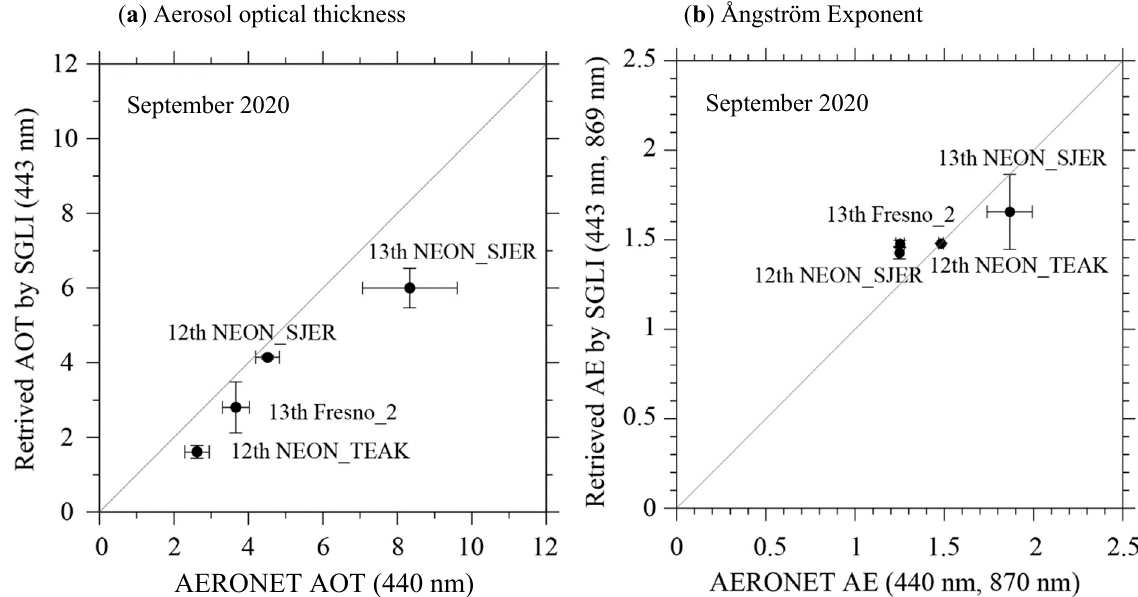
Figure 8. Comparison of aerosol properties derived from two different data collection methods— ground-based observations (AERONET) and satellite observations (SGLI). ( a ) Properties of aerosol optical thickness (AOT). ( b ) Properties defined by the Ångström exponent (AE). Satellite observation data are plotted on the vertical axis. Ground-based observation data are plotted on the horizontal axis. The three AERONET observation sites are plotted as NEON_SJER, Fresno_2, and NEON_Teak. Time variations are represented by the standard deviation of both measurements, indicated by error bars. The dates are plotted as 12th (12 September 2020) and 13th (13 September 2020). All measurements were taken over Area-S (Figure 4).